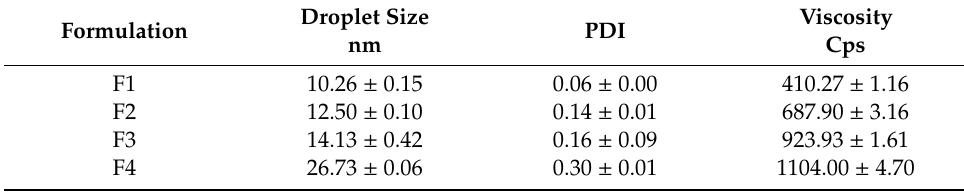
Table 2. Droplet size, polydispersity index (PDI), and viscosity of drug-loaded